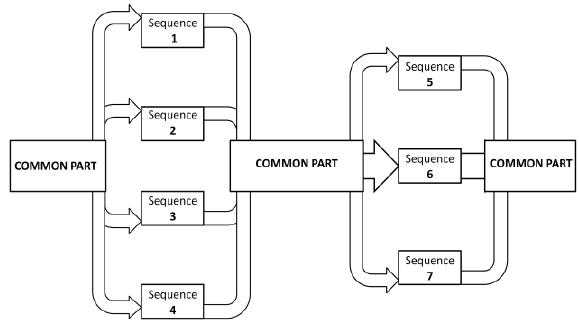
Figure 2 . Repetitive and variable structures of Mademoiselle Paradis